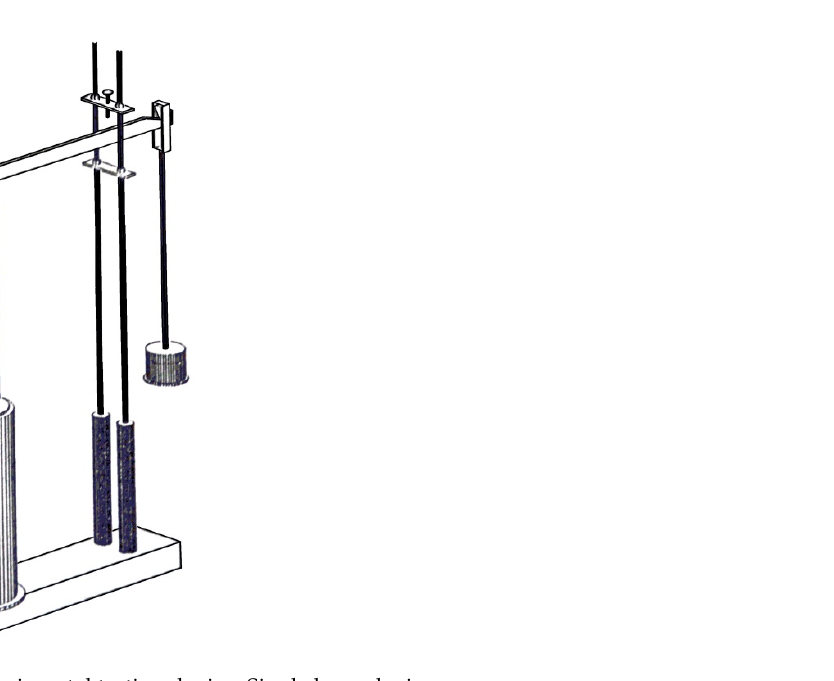
Figure 3. Experimental testing device. Single lever device.